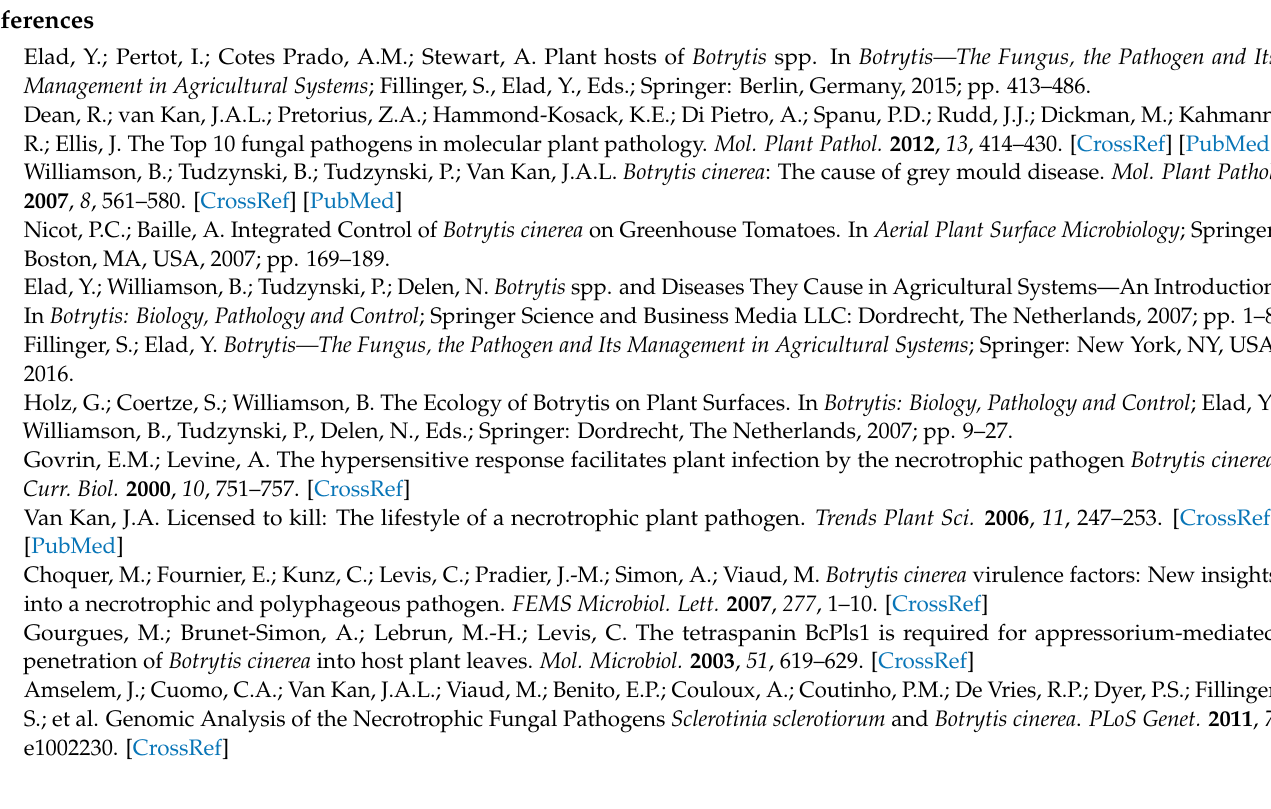
Table S13: List of 96 B. cinerea DEGs that were only upregulated in P. patens . DEGs were considered when log2 FC was ≥ 2 and FDR ≤ 0.05 in at least one time point of each plant species. For samples where no significant difference with control was observed (FDR > 0.05) or no data was available, the log2 FC was assigned as cero. Table S14: List of 288 B. cinerea DEGs that were only upregulated in all angiosperms and not in P. patens . DEGs were considered when log2 FC was ≥ 2 and FDR ≤ 0.05 in at least one time point of each plant species. For samples where no significant difference with control was observed (FDR > 0.05) or no data was available, the log2 FC was assigned as cero. Table S15: List of 111 B. cinerea DEGs that were only downregulated in P. patens . DEGs were considered when log2 FC was ≤ − 2 and FDR ≤ 0.05 in at least one time point of P. patens . For samples where no significant difference with control was observed (FDR > 0.05) or no data was available, the log2 FC was assigned as cero. Table S16: List of 93 B. cinerea DEGs that were only downregulated in all angiosperms and not in P. patens . DEGs were considered when log2 FC was ≤ − 2 and FDR ≤ 0.05 in at least one time point of each plant species. For samples where no significant difference with control was observed (FDR > 0.05) or no data was available, the log2 FC was assigned as